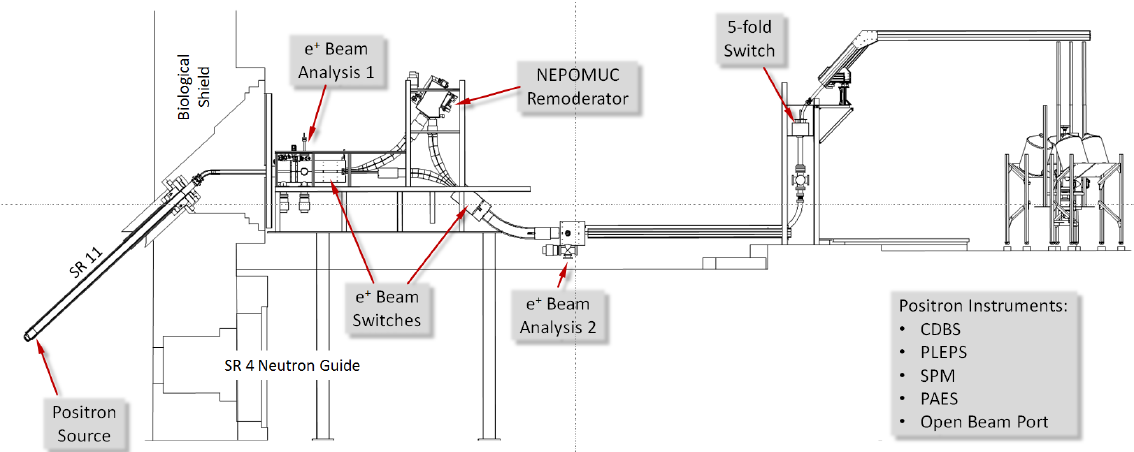
Figure 2: Schematic drawing of NEPOMUC and the positron beam